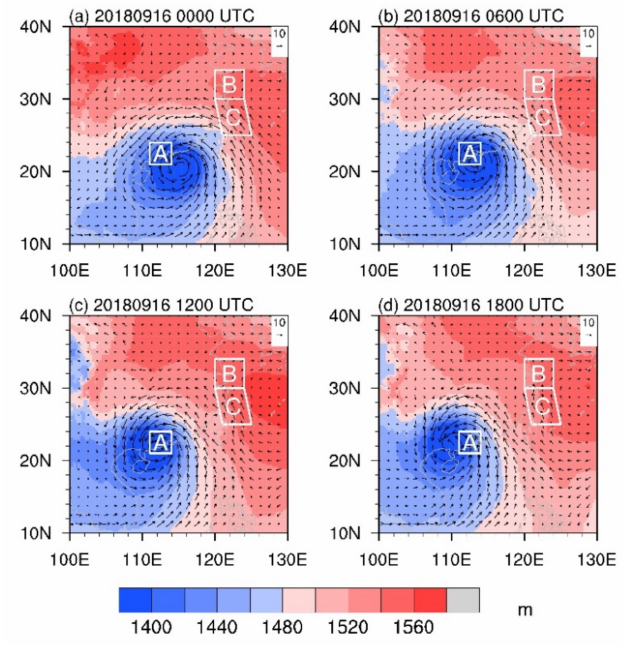
Figure 3. The 850 hPa geopotential height and wind from 0 to 18 UTC on 16 September 2018. ( a ) 0000 16 September, ( b ) 0600 16 September, ( c ) 1200 16 September and ( d ) 1800 16 September. A stands for the Pearl River Delta, B stands for the Yangtze River Delta and C stands for the water vapor transport